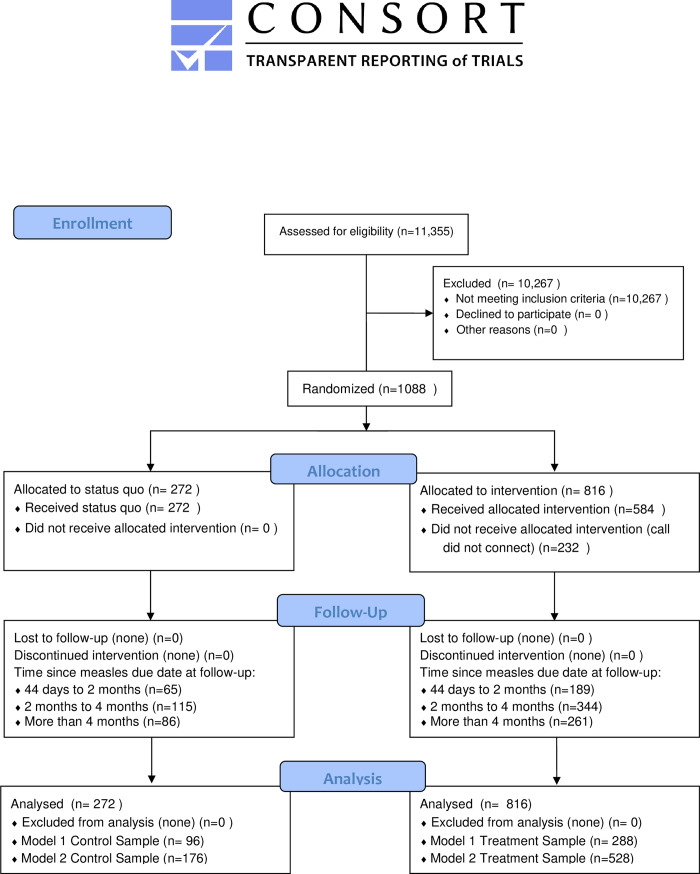
CONSORT 2010 flow diagram.